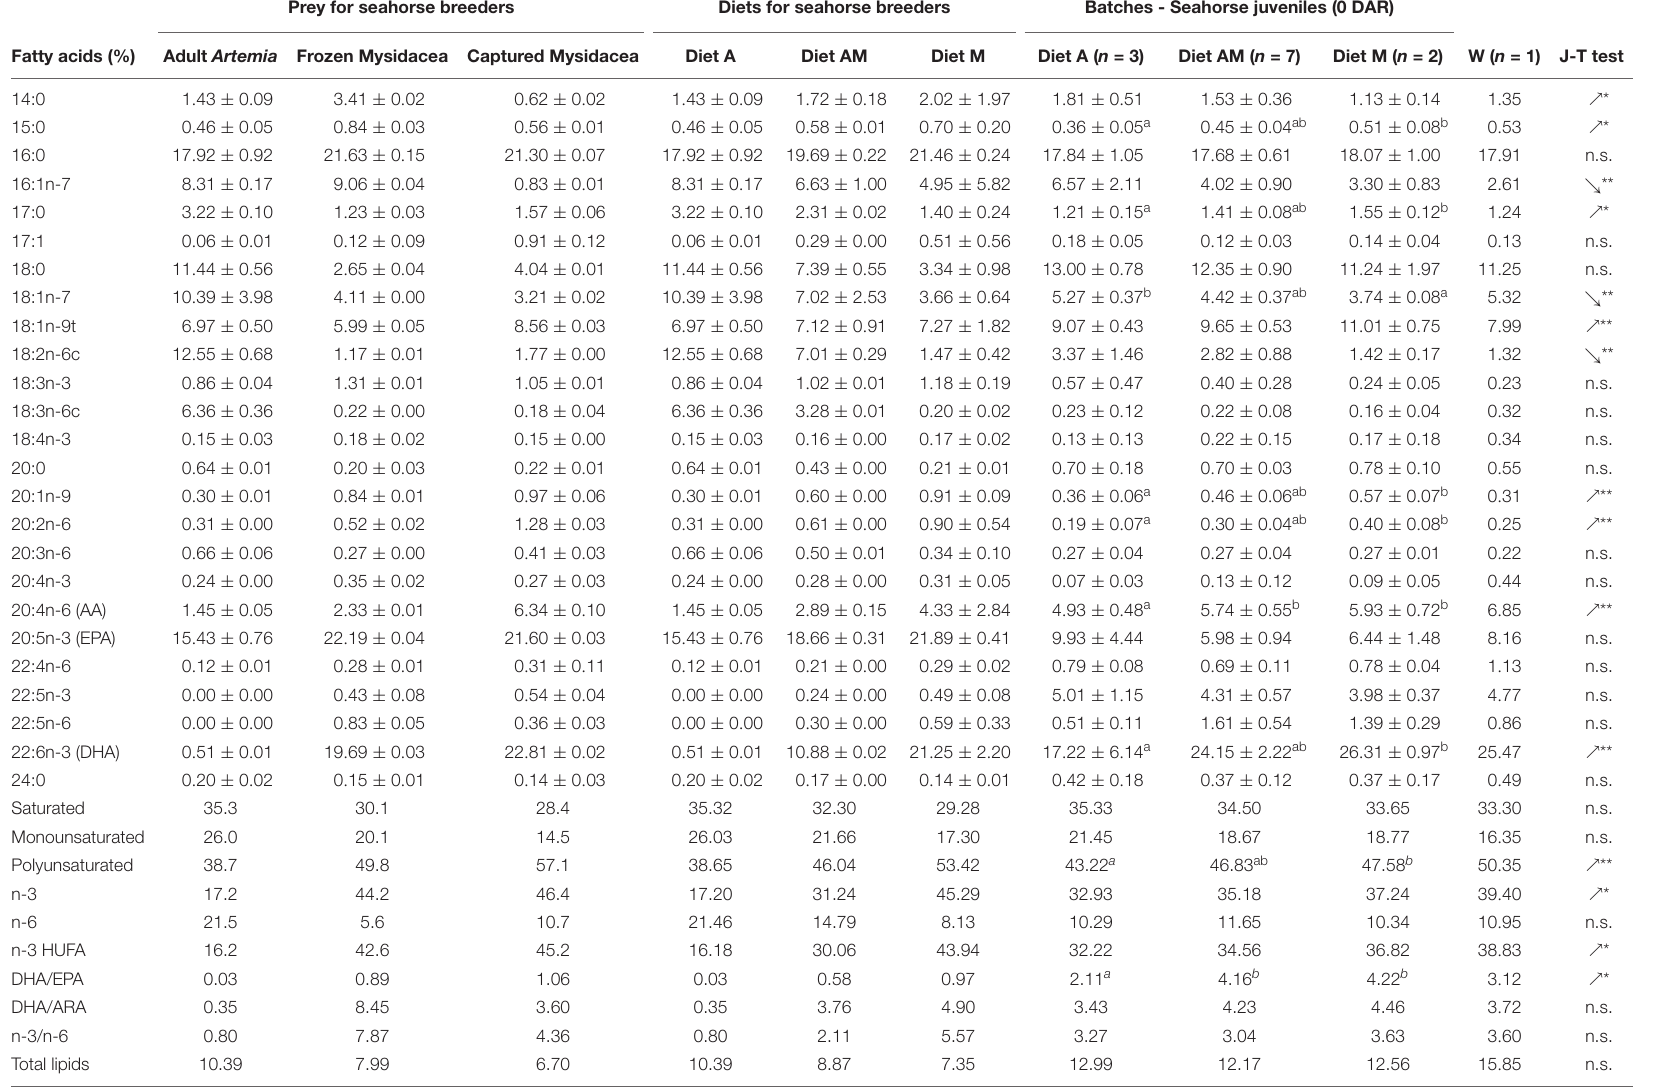
TABLE 2 | Total lipids (% dry weight) and fatty acids (relative percentage) in prey ( n = 2), diets and newborn seahorses. Prey for seahorse breeders Diets for seahorse breeders Batches - Seahorse juveniles (0